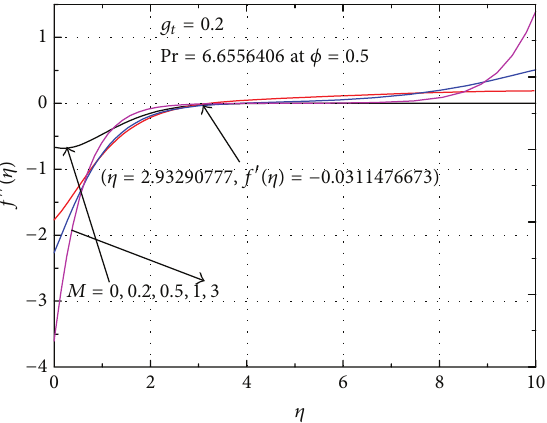
Figure 5: Effect of magnetic parameter on temperature gradient.